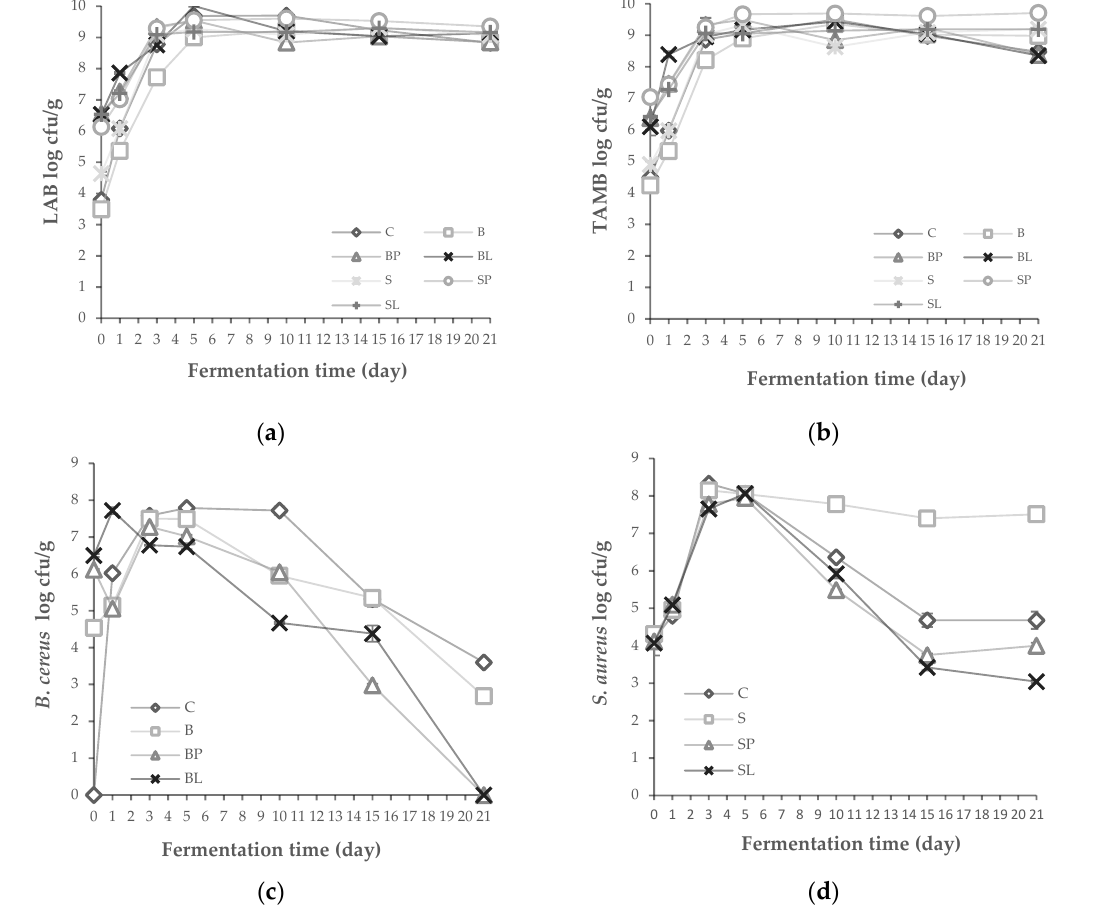
Figure 3. The microbial changes in ( a ) LAB, ( b ) TAMB, ( c ) B. cereus , and ( d ) S. aureus in the tarhana samples during fermentation produced by inoculating bacteriocin producers and indicator strains. Tarhana dough samples: (C) Control; (B) Inoculated B. cereus ATCC 11778 10 4 cfu/g, (BP) Inoculated B. cereus ATCC 11778 10 4 cfu/g, P. acidilactici PFC69 10 6 cfu/g; (BL) B. cereus ATCC 11778 10 4 cfu/g, L. lactis PFC77 10 6 cfu/g; (S) Inoculated S. aureus ATCC 29213 10 4 cfu/g; (SL) Inoculated S. aureus ATCC